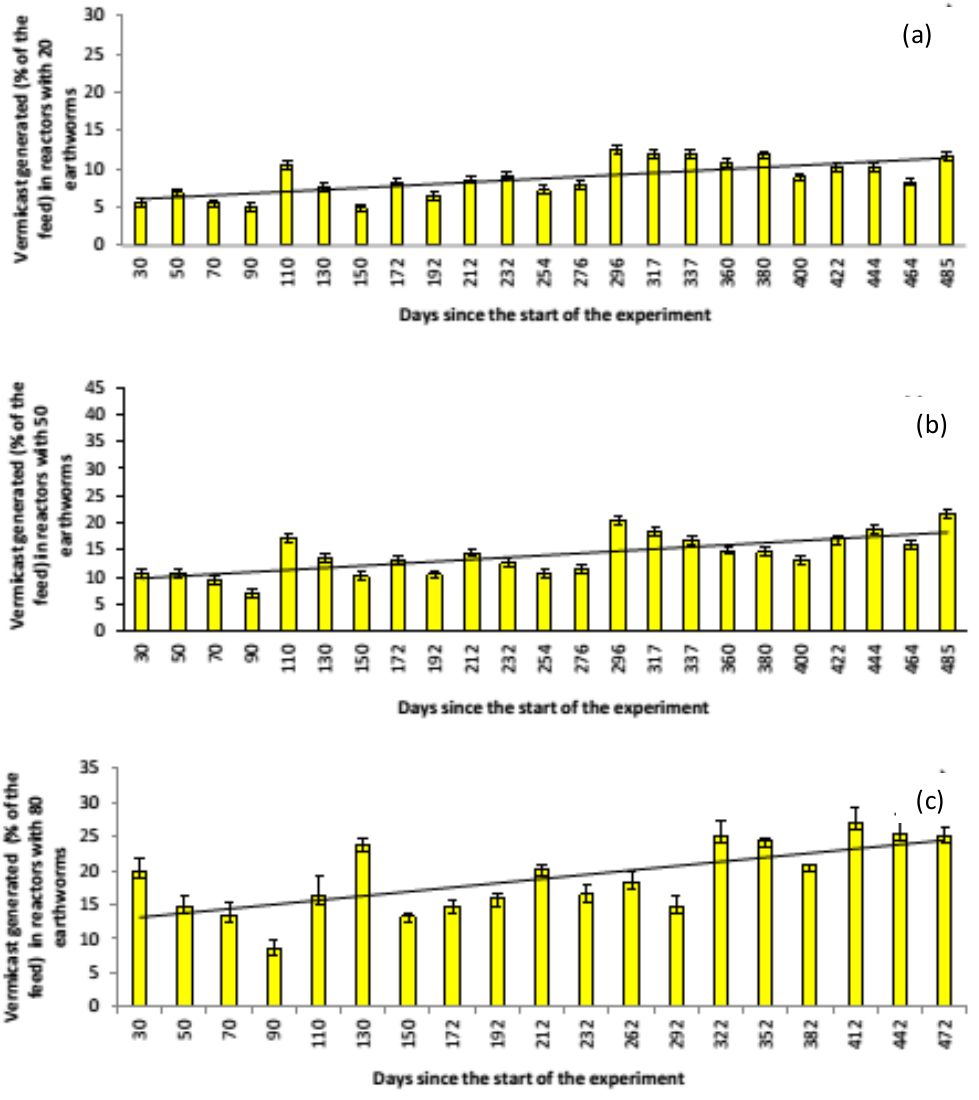
Figure 2. Trend in the generation of vermicast as a function of time in pulse-fed, semi-continuous reactors operated with ( a ) 20, ( b ) 50, and ( c ) 80 earthworms and fed with fresh lantana.